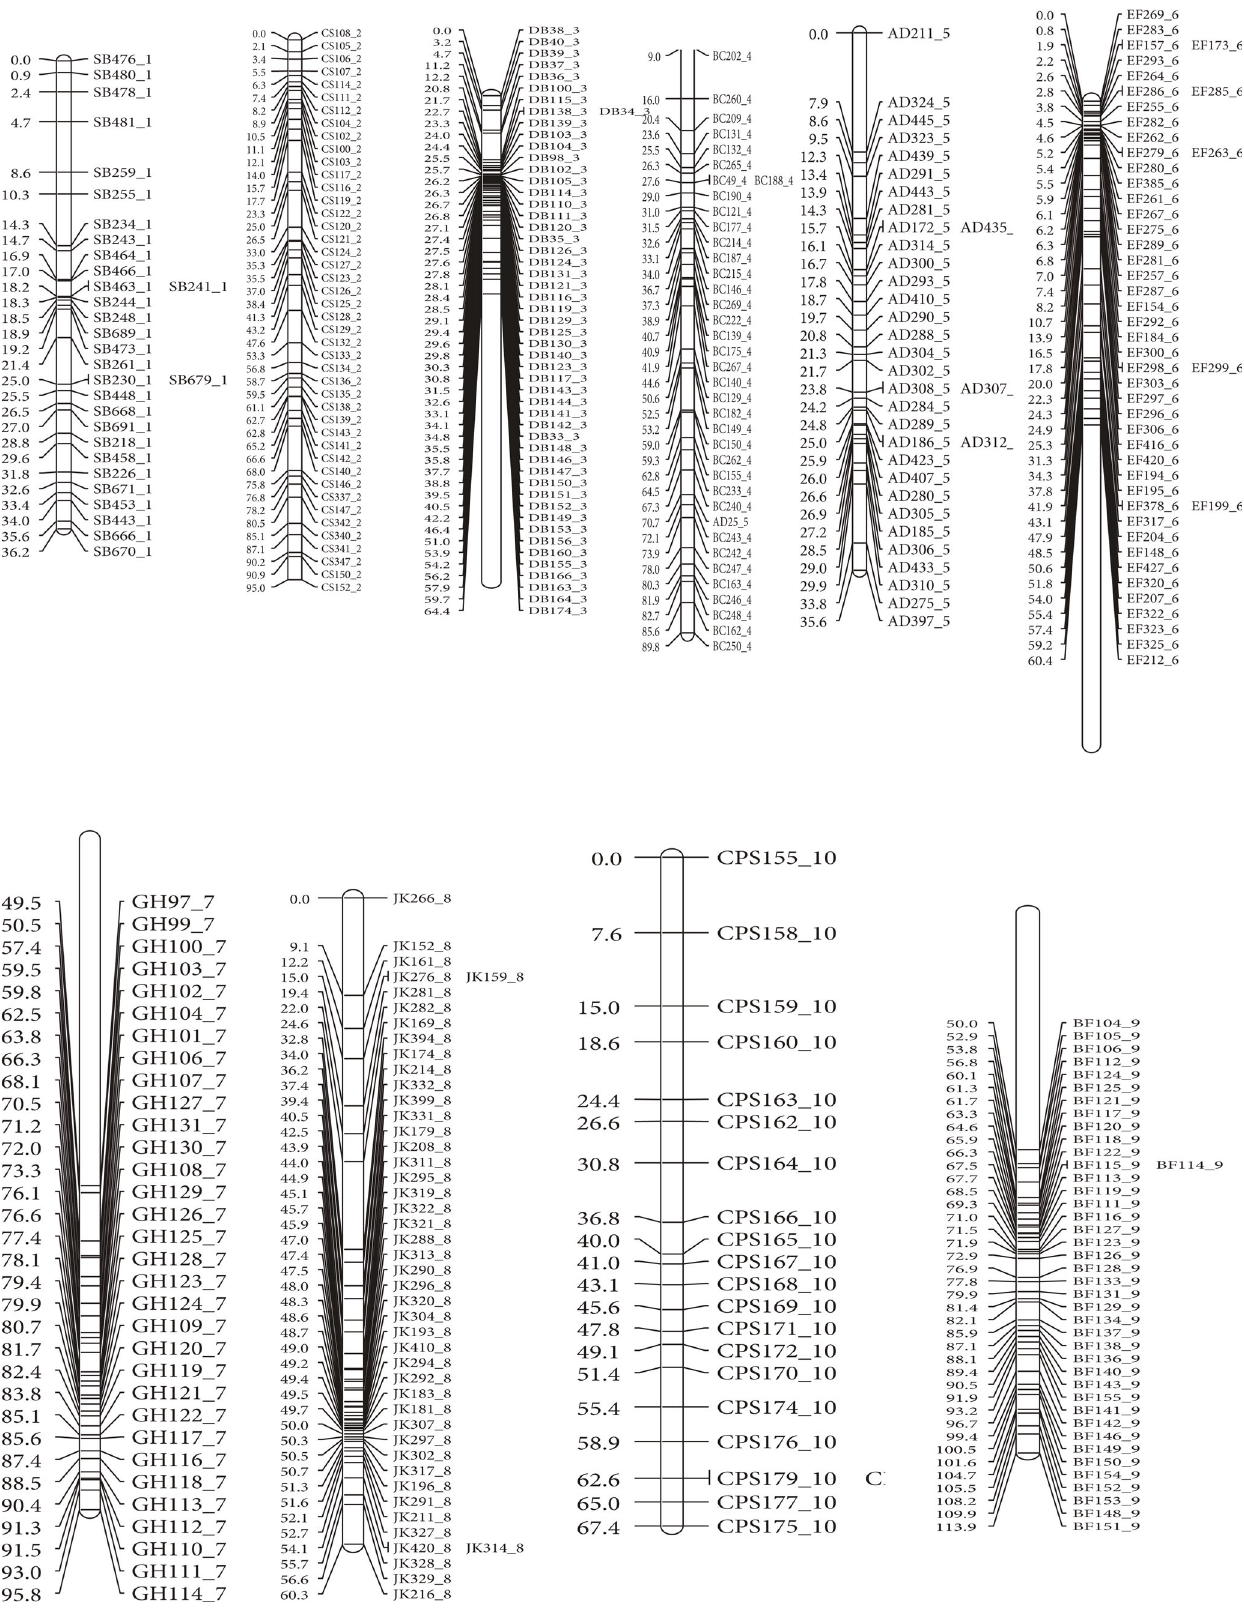
Figure 1: Genetic map of ICSV745 × PB15520 recombinant inbred lines of sorghum generated using 4,955 polymorphic SNP